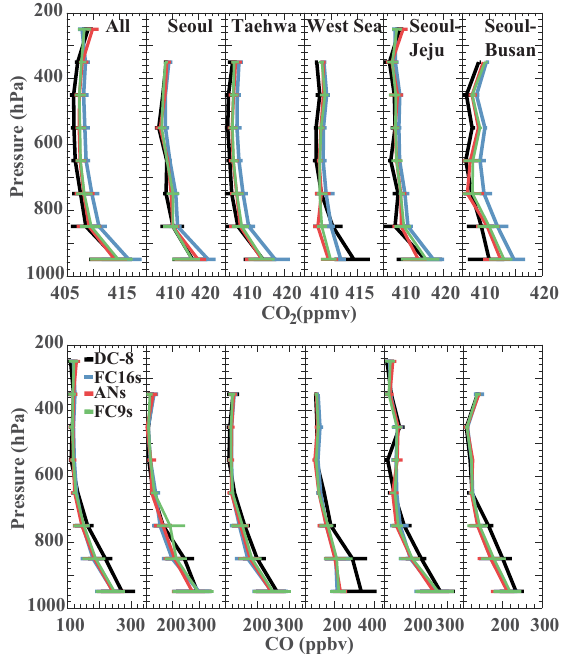
Figure 4. Averaged vertical profiles of CO 2 and CO mixing ratios from the DC-8 aircraft data and CAMS for each flight group. Hori- zontal bars correspond to the interquartile ranges (between 25th and 75th percentiles) of the layer